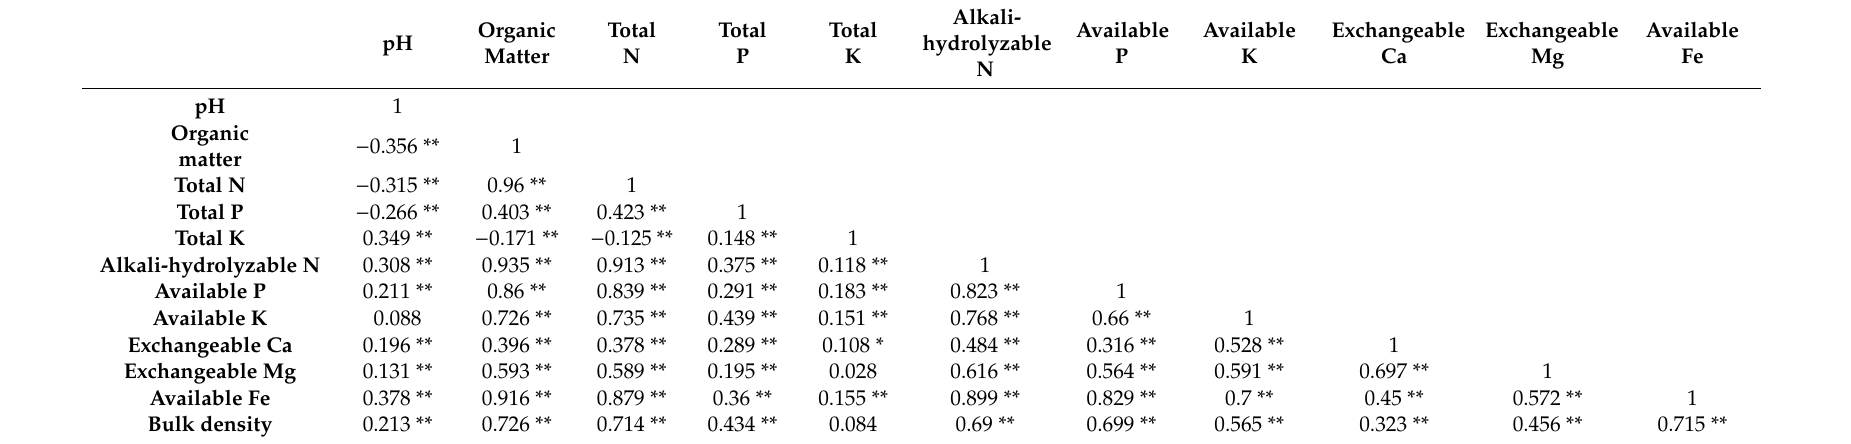
Table 4. The correlation analysis of soil nutrition and stand